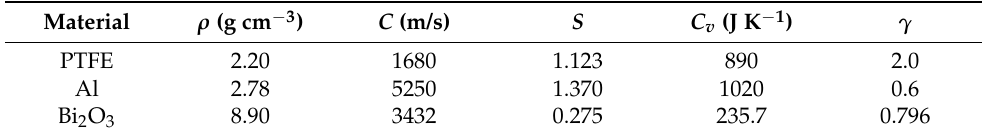
Table 4. The material property parameters related to the shock